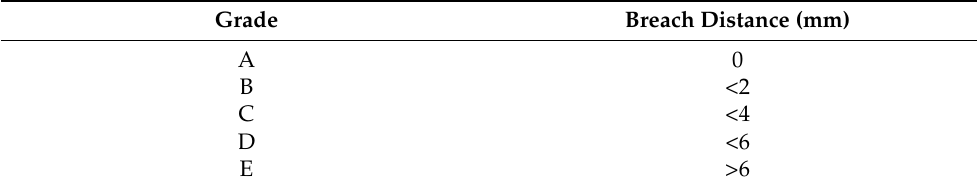
Table 2. Gertzbein-Robbins classification system of pedicle screw accuracy.